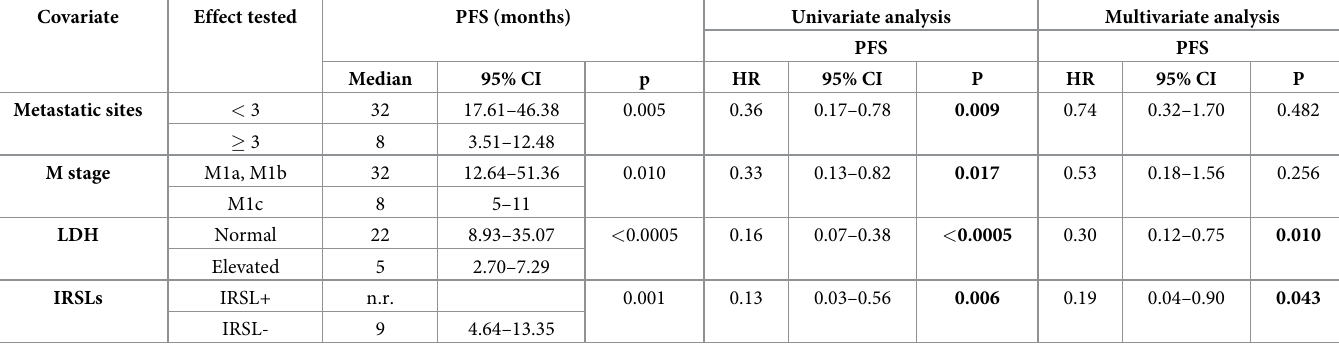
n.r. not reached; PFS Progression-free survival; HR hazard ratio; CI confidence interval; IRSLs+ presence of immune related skin lesions; IRSLs- absence of